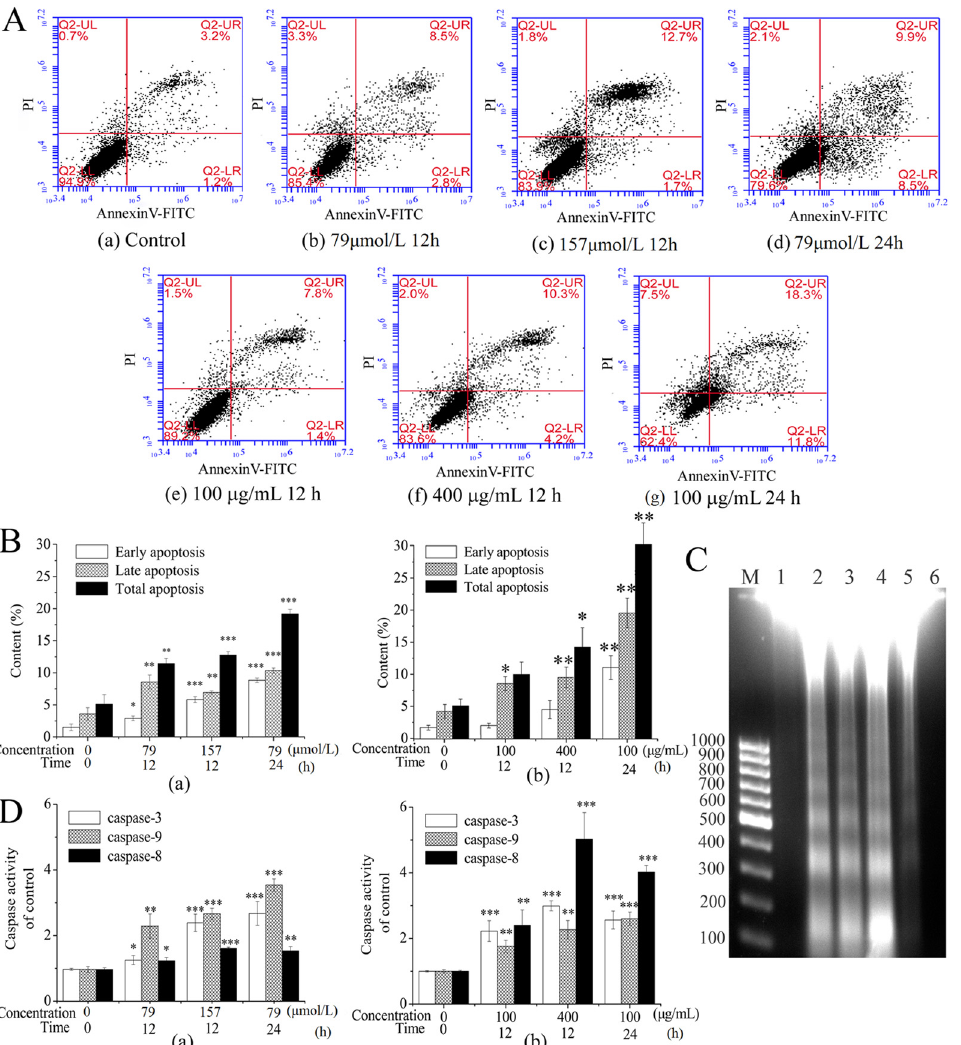
Fig 3. Apoptosis Induced by DMQ and H-EtOAc fraction of HepG2 Cells. A. Apoptosis was measured on HepG2 cells treated with gradient DMQ (a)-(d) and H-EtOAc fraction (e)-(g) by flow cytometry. B. The apoptosis rates were calculated of DMQ (a) and H-EtOAc fraction (b) on HepG2 cells. C. DNA ladder. Lane 1: Control; Lane 2 – 4: 79 μ mol/L at 24 h, 157 μ mol/L at 12 h and 157 μ mol/L at 24 h for DMQ; Lane 5: 400 μ g/mL at 24 h for H-EtOAc fraction; Lane 6: Negative group. D. The activities of caspase-3, -8, -9 proteases of HepG2 cells treated with DMQ (a) and H-EtOAc fraction (b). Values are means ± SD of three independent experiments. * ( p < 0.05), ** ( p < 0.01) and *** ( p < 0.001) represented significant differences compared to the control.